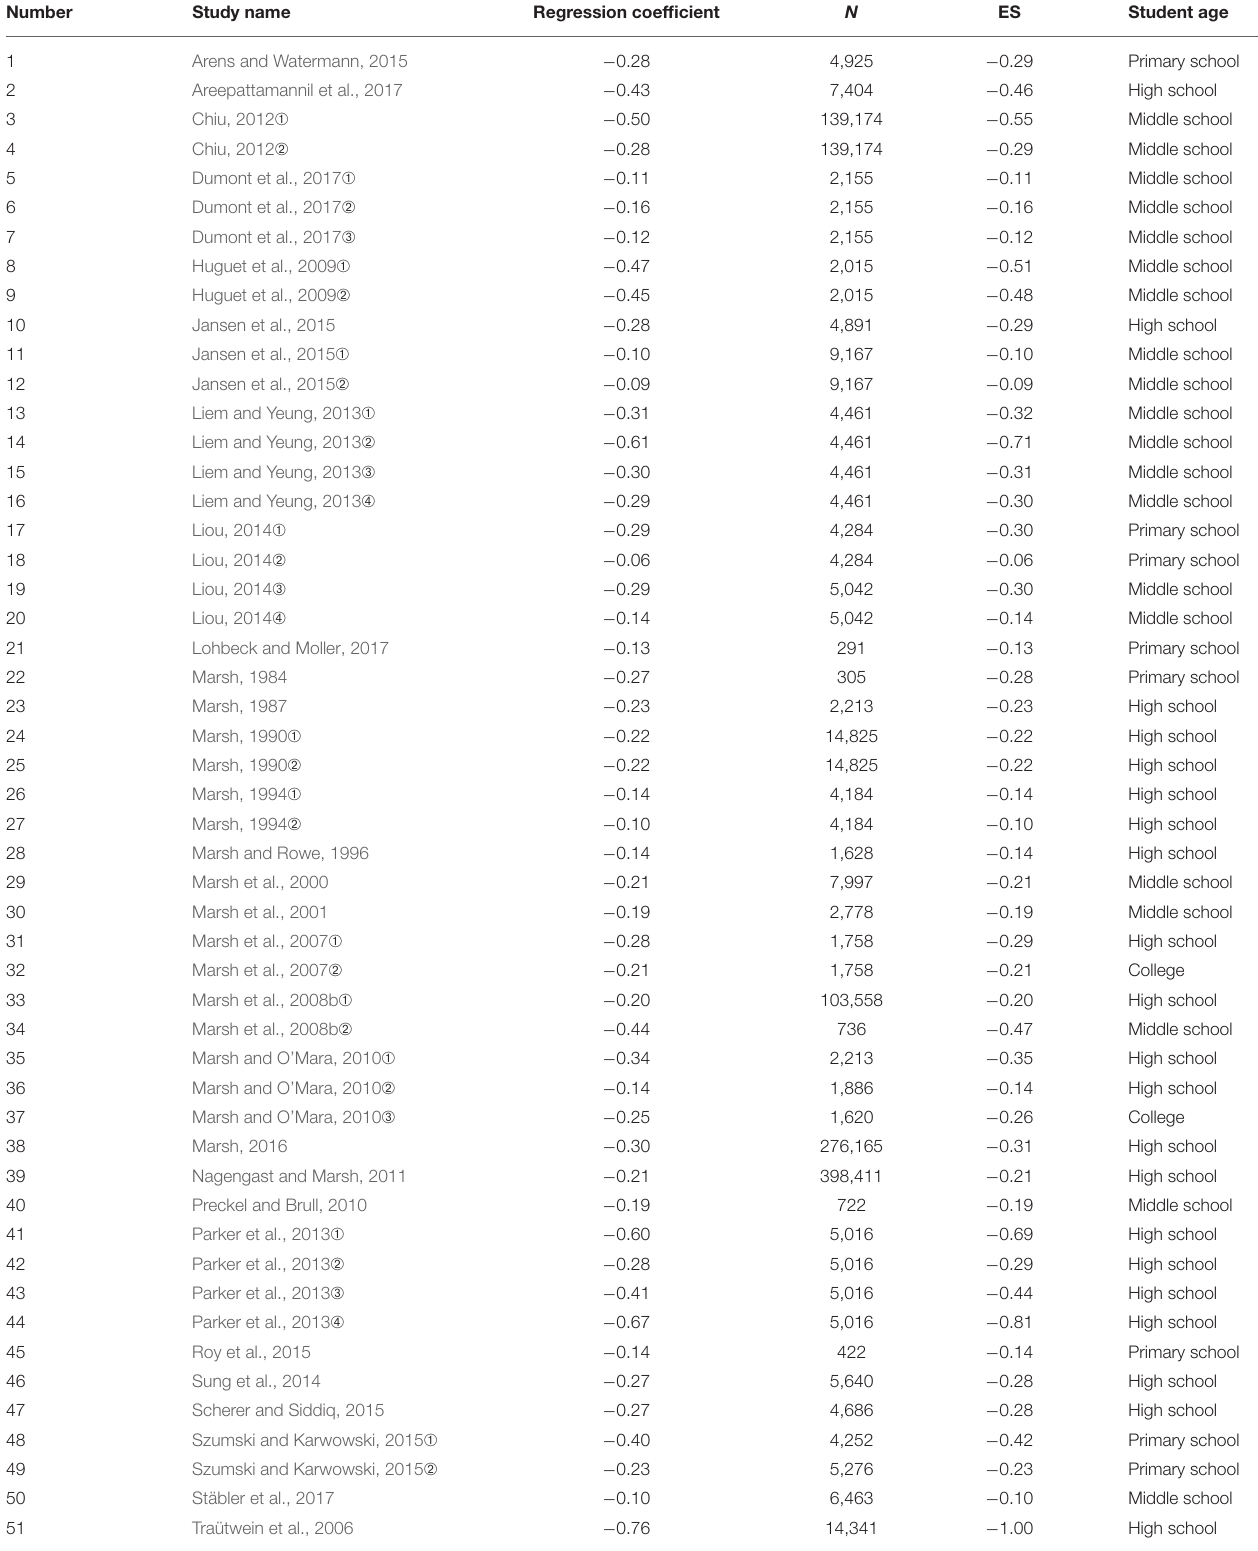
TABLE 1 | Summary of studies included in the meta-analysis